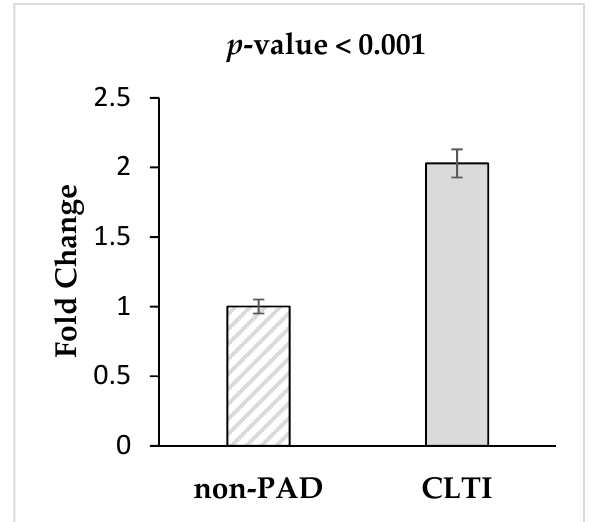
Figure 3. Validation of miRNA-1827 in age-cardiovascular risk factors-matched non-PAD controls ( n = 10) and CLTI ( n = 10) patients. miRNA-1827 was validated in a new cohort of patients via qRT-PCR. Compared with miRNA levels in matched control, miRNA-1827 remained significantly increased in CLTI patients (2-folds, p -value < 0.001).